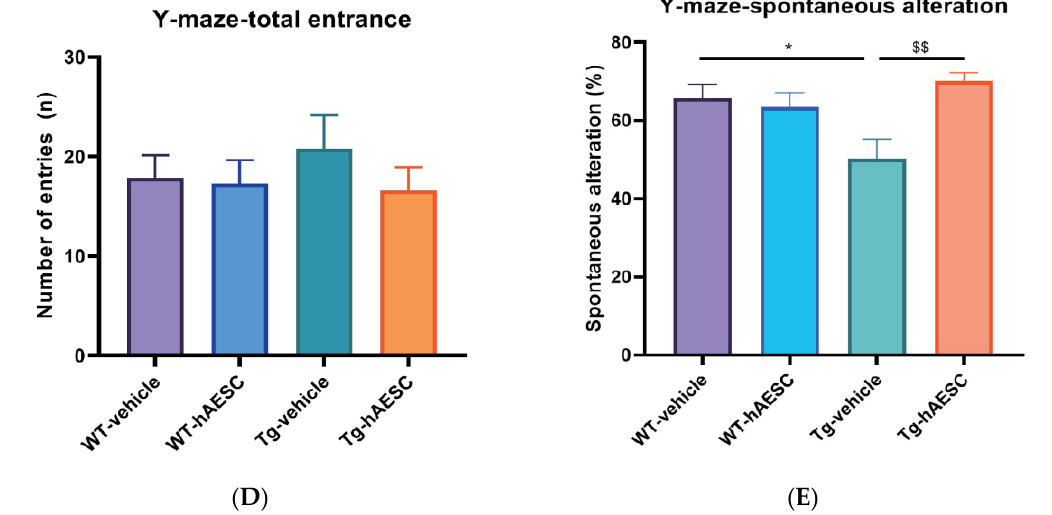
Figure 2. Effects of hAESCs transplantation on cognitive deficits in Tg2576 Alzheimer’s disease transgenic mice. ( A ) The Morris water maze (MWM) test was performed 3 months after intracerebral injection. Training trials were performed on 6 consecutive days, and the escape latencies of the mice were recoded. ( B ) The MWM probe test was conducted 48 h after the final training trial. ( C ) Representative swim paths in the MWM. ( D ) The total number of arm entries in the Y-maze was recorded. ( E ) The rate of spontaneous alternation in the Y-maze was calculated. All data represent the mean ± standard error of the mean ( n = 10–15 per group). Data from the MWM test were analyzed by two-way ANOVA followed by Bonferroni’s multiple comparisons and data from the Y-maze test were analyzed by one-way ANOVA followed by Tukey’s multiple comparisons test. WT-vehicle, * p < 0.05, ** p < 0.01, *** p < 0.001; WT-hAESC, ## p < 0.01, ### p < 0.001; Tg-hAESC, $ p < 0.05, $$ p < 0.01 compared to Tg-vehicle. ANOVA, analysis of variance; hAESCs, human amniotic epithelial stem cells; Tg, transgenic.